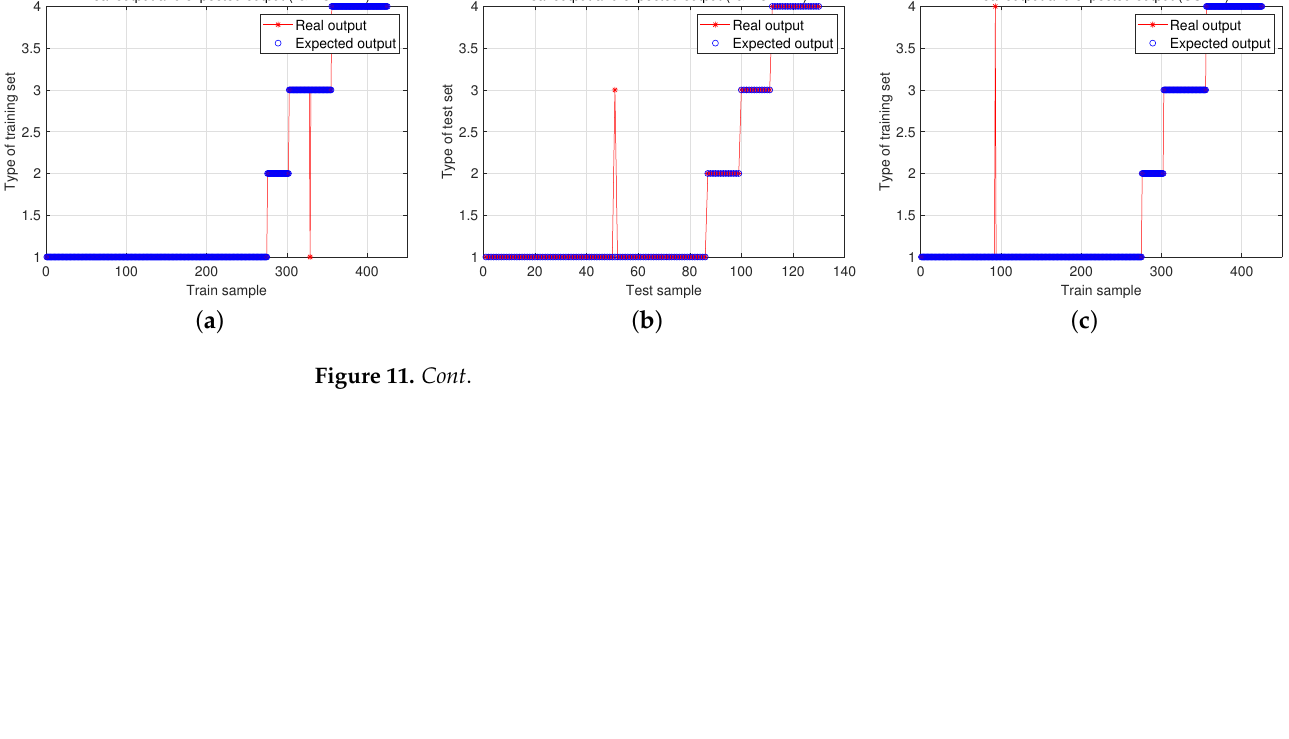
train sample classification for different methods, respectively. ( b , d , f ) are the results of testsample classification for different